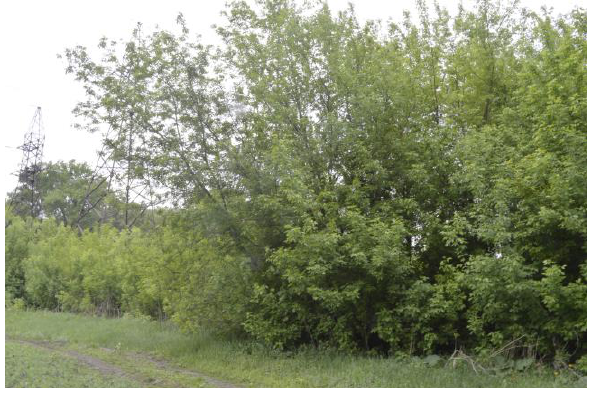
Fig. 6. Chelidonio-Aceretum negundi The association Chelidonio-Aceretum negundi (Fig. 6). These communities are distributed in 1–5- row interfield blown afforestation belts with a width of 6–15 m, on grey forest and chernozem